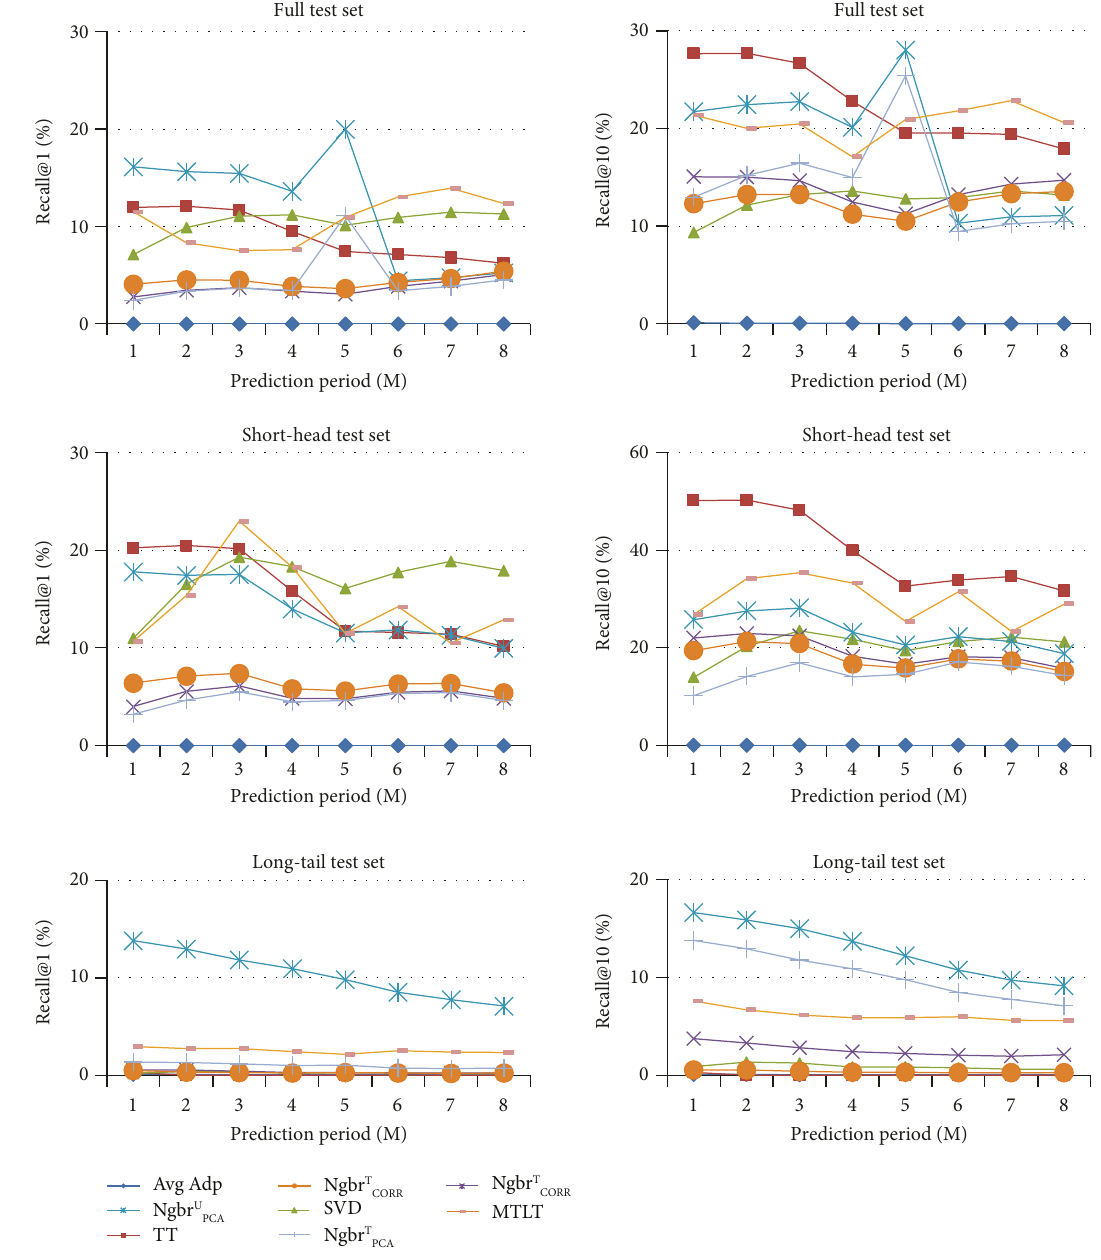
Figure 4: Prediction period